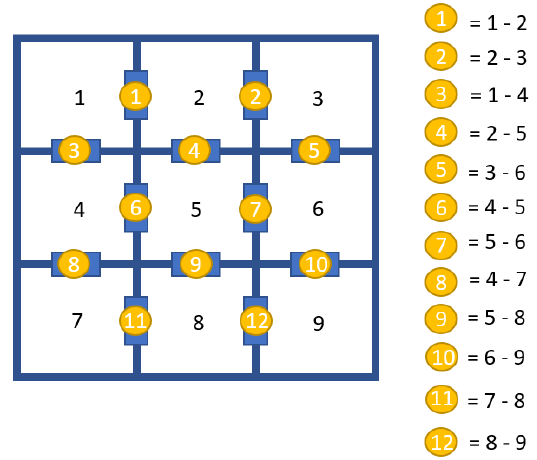
Figure 2. A graph representation of Diff Array.